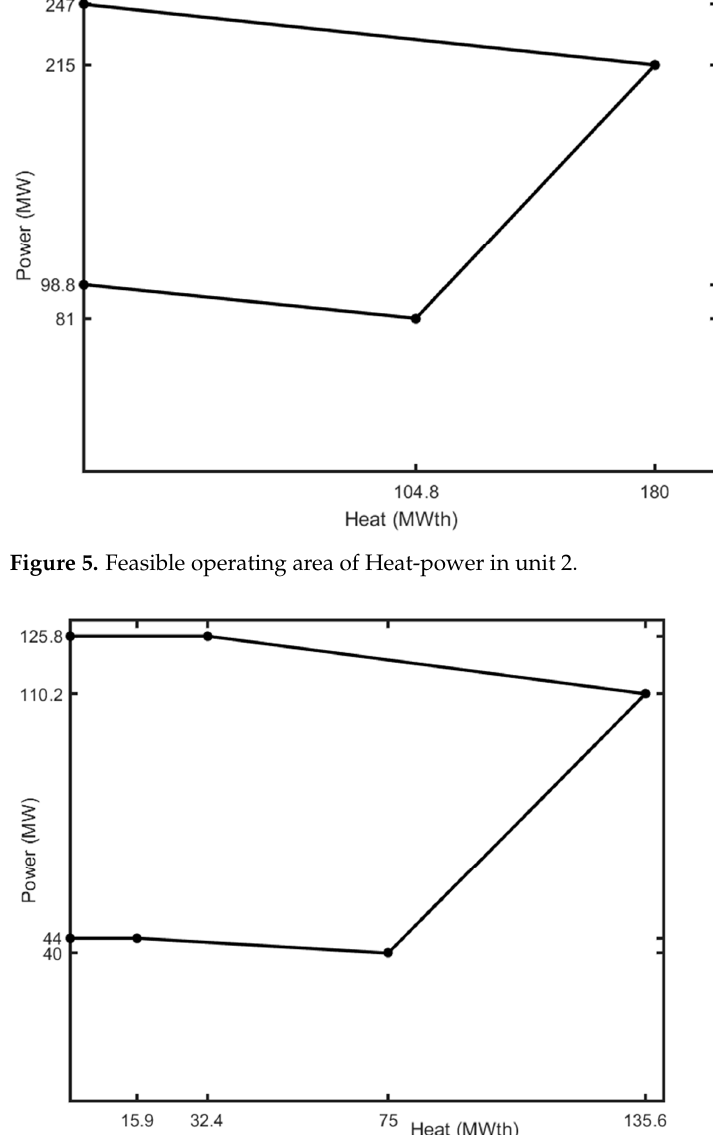
Figure 6. Feasible operating area of Heat-power in unit 3.